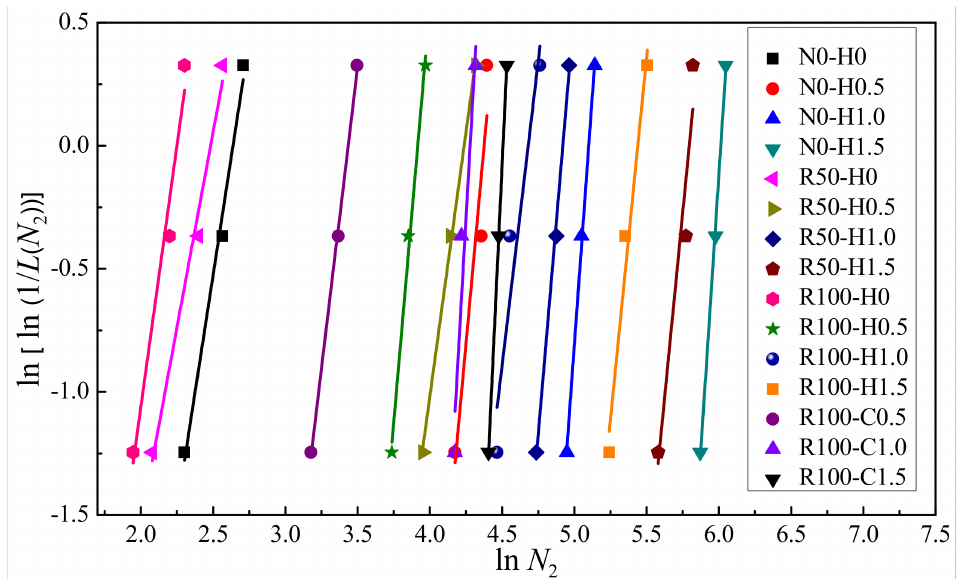
Figure 12. Linear regression of N 2 in Weibull